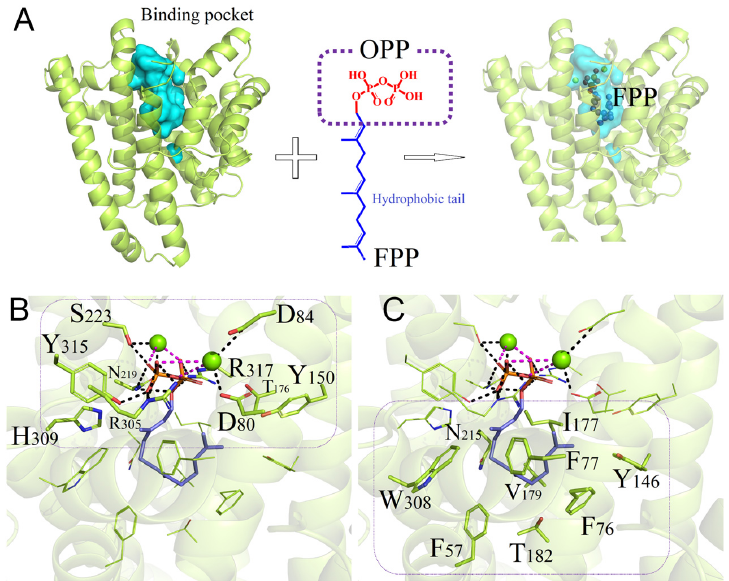
Figure 4. Binding model of the wild-type PentS with ligand FPP. ( A ) Molecular docking analysis of PentS with substrate FPP. The binding cavity was colored in cygan. The ligand FPP consists of two parts: the hydrophilic pyrophosphate head group OPP and the hydrophobic prenyl tail. ( B ) Binding region of PentS cavity with the head group OPP. Representative polar or charged residues are indicated in the rounded rectangle. Polar interaction and metal ion chelation are represented by black dashed lines and fuchsia dashed lines, respectively. ( C ) Binding region of PentS cavity with the hydrophobic prenyl tail. Representative aromatic residues or aliphatic residues are indicated in the rounded rectangle. The residues and FPP are shown as sticks and Mg 2+ ions are represented as green